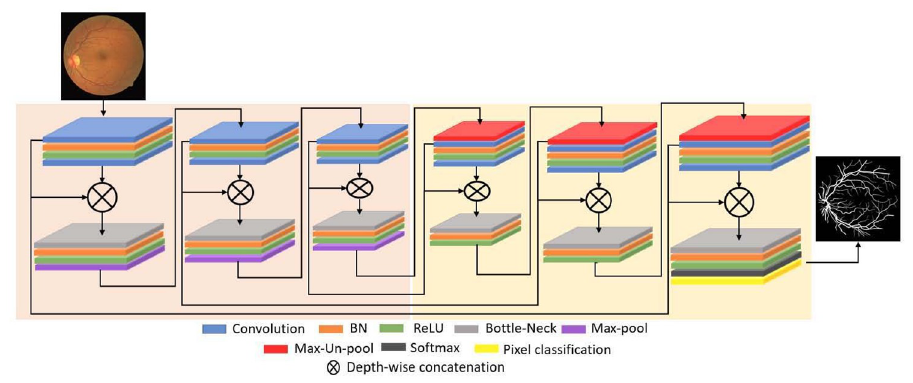
Fig 3. Architecture of DAVS-Net used for vessel segmentation in our